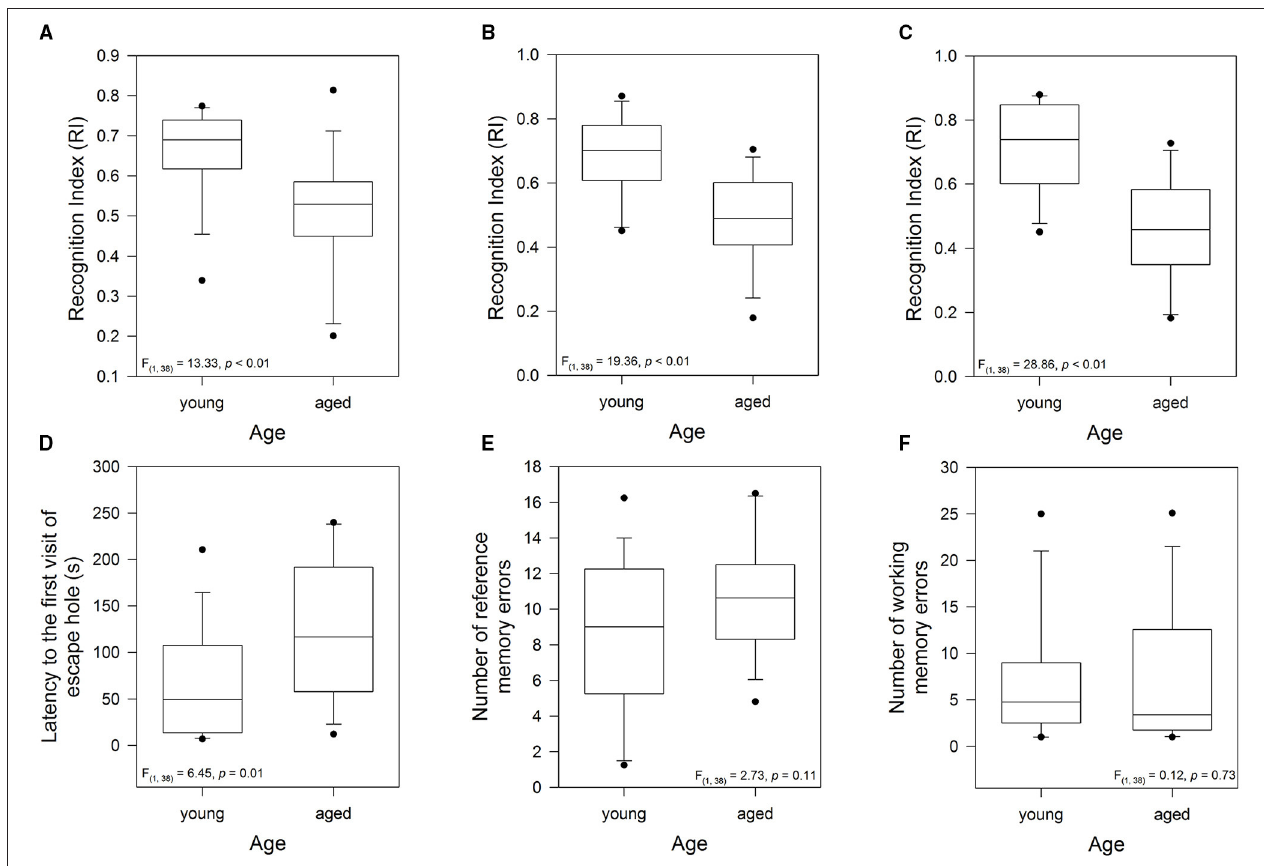
FIGURE 3 | Evaluation of the cognitive performance of young group (12-, and 24-months-old, n = 19) and aged group (38-, 56-, and 75-months-old, n = 20): short-term memory measured by (A) the Recognition Index (RI) of the Social Interaction test, (B) the RI of the novel local recognition test, and (C) the RI of the novel object recognition test. Long-term memory measured during the test phase of the Barnes maze: (D) latency to the first visit of the escape hole, (E) reference memory errors to find the escape hole (every first visit of a non-escape hole in each trial), and (F) working memory errors (repeated visits to the same non-escape hole in the same trial). The data were analyzed statistically by one-way ANOVA followed by Tukey’s post hoc